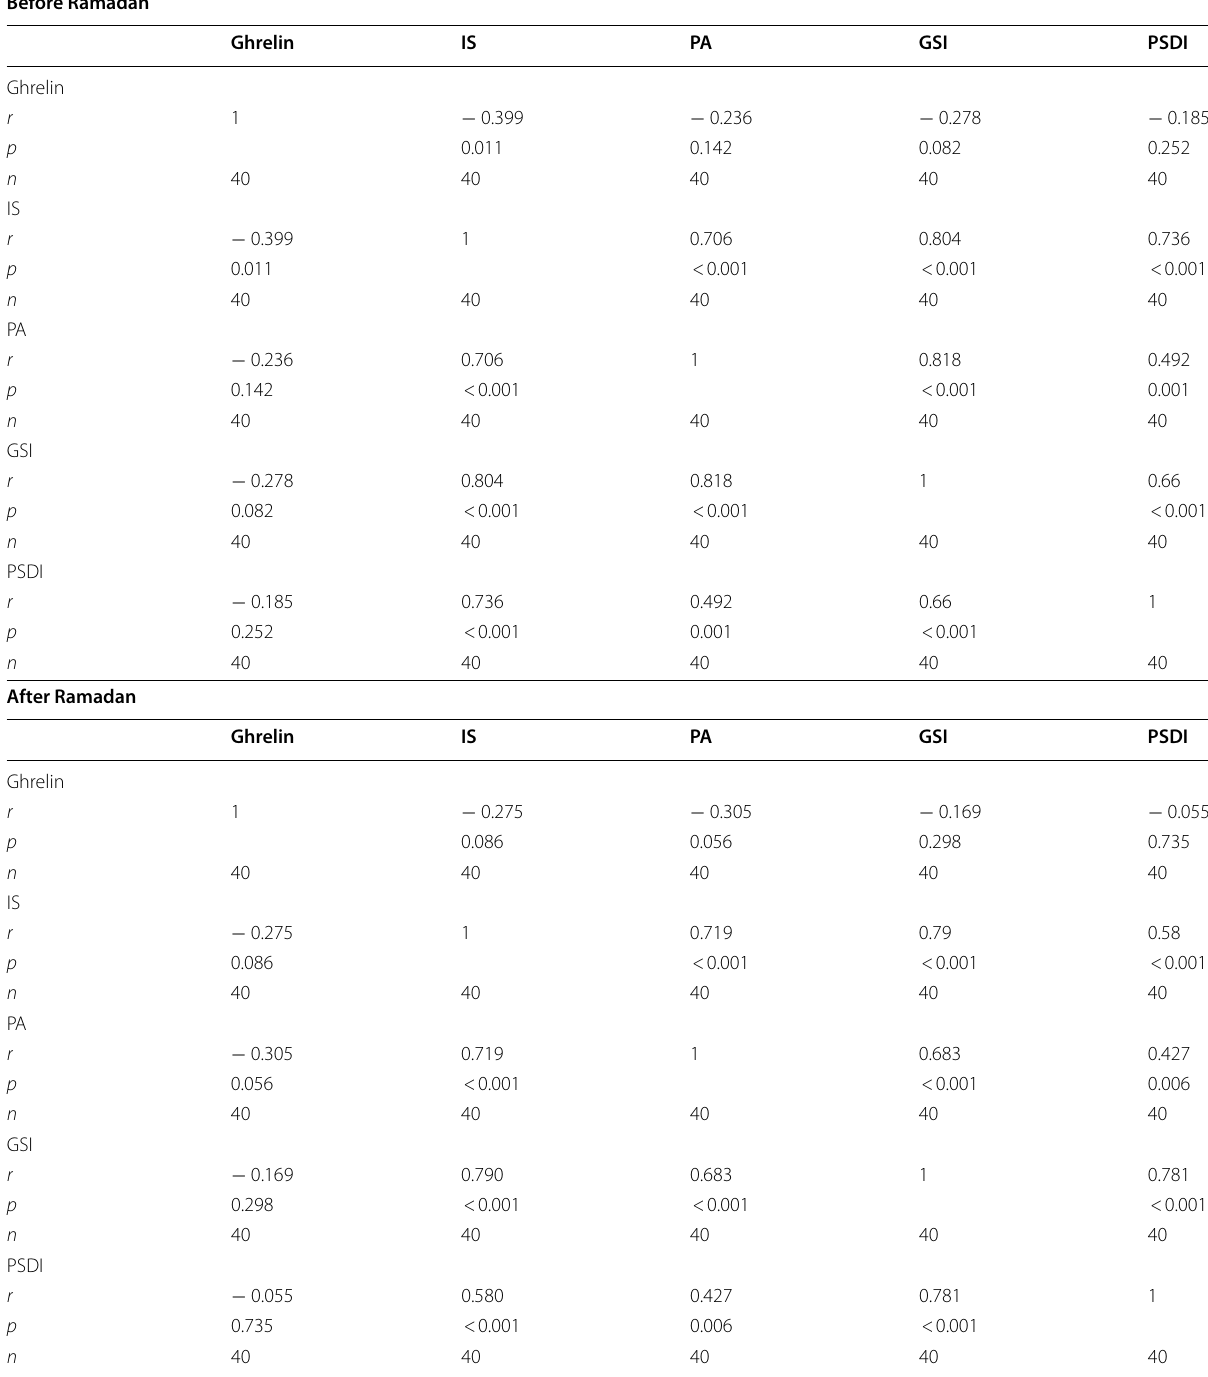
Table 4 Correlation between the participants’ plasma Ghrelin levels and scale